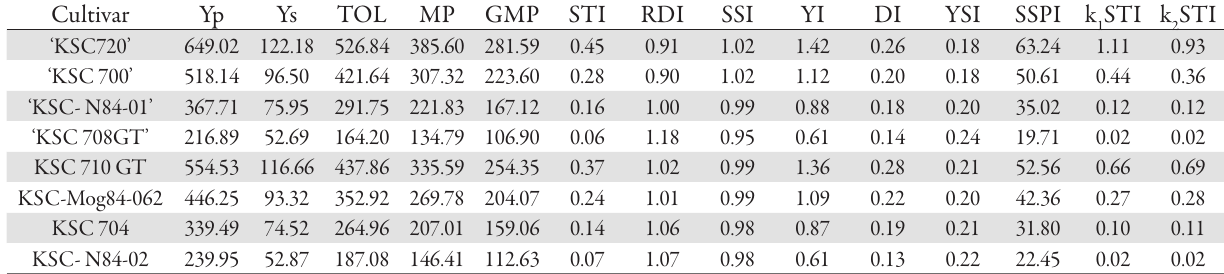
Tab. 2. Resistance/tolerance indices of canola cultivars under stress and non-stress condition